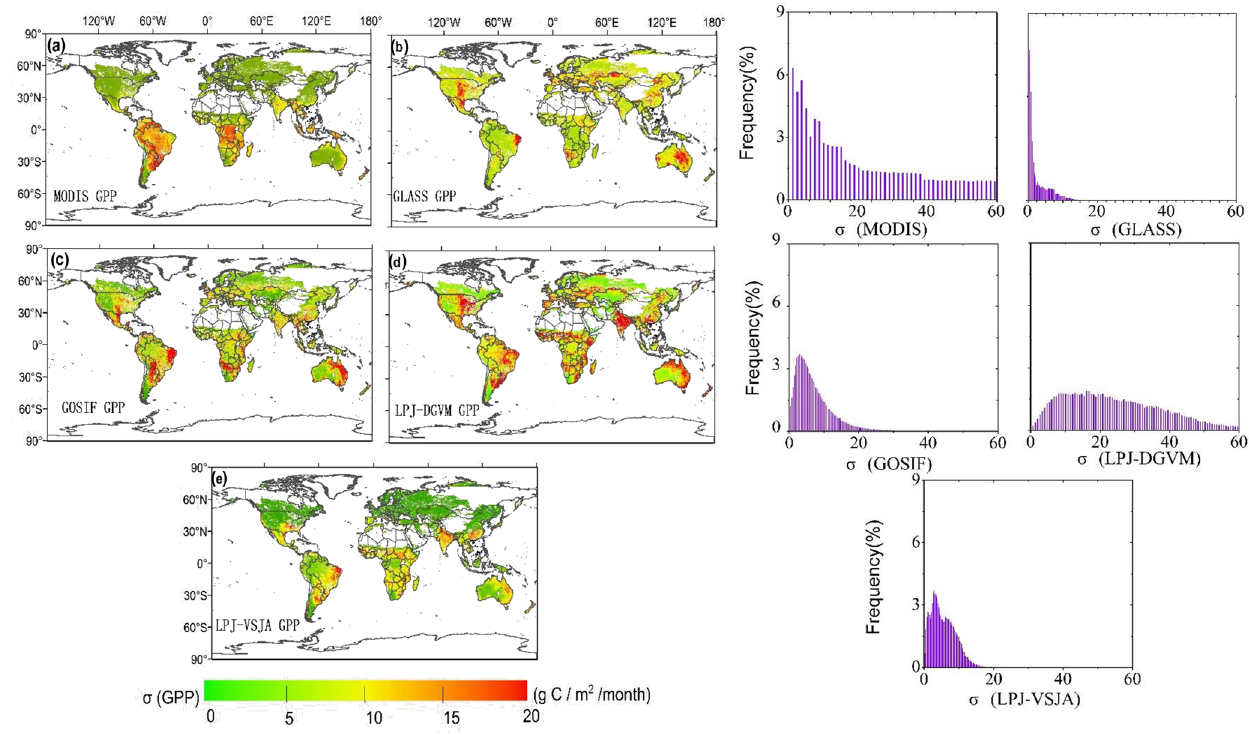
Figure 13. Spatial distribution and histograms of error standard deviation ( σ ) for global GPP products: MODIS (a) , GOSIF (b) , GLASS (c) , LPJ-DGVM (d) , and LPJ-VSJA (e)